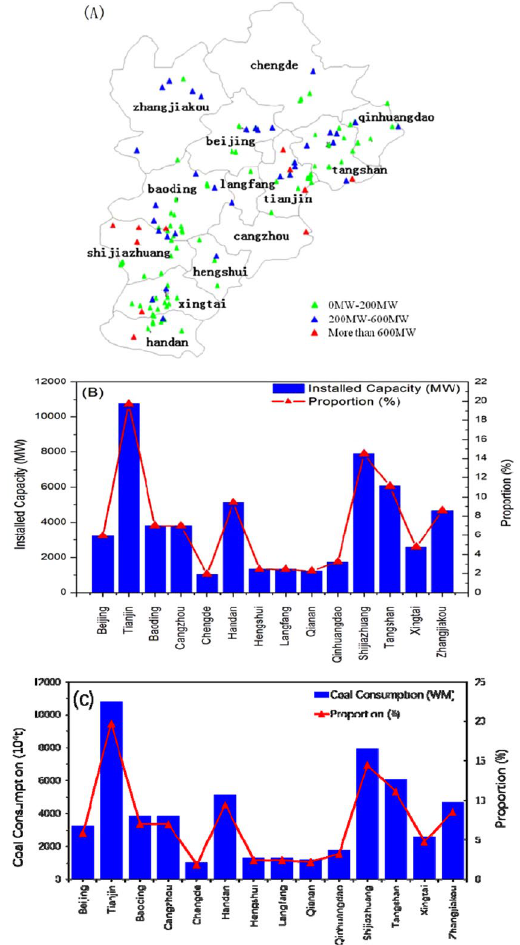
Figure 3. BTH region. ( A ) Locations of thermal power plants; ( B ) total capacity of thermal power plants and their distribution by city; ( C ) coal consumption distribution in the BTH region in 2013. The maps were created by NCAR Command Language (NCL) (http://www.ncl.ucar.edu/).